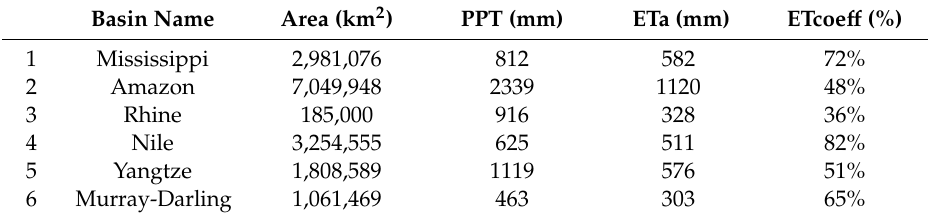
Table 5. Summary statistics for the six major river basins shown from left to right in Figure 5: basin name, area in km 2 , average annual ETa (mm) and precipitation (mm), and basin-wide ETcoe ff (ETa / PPT) (%).